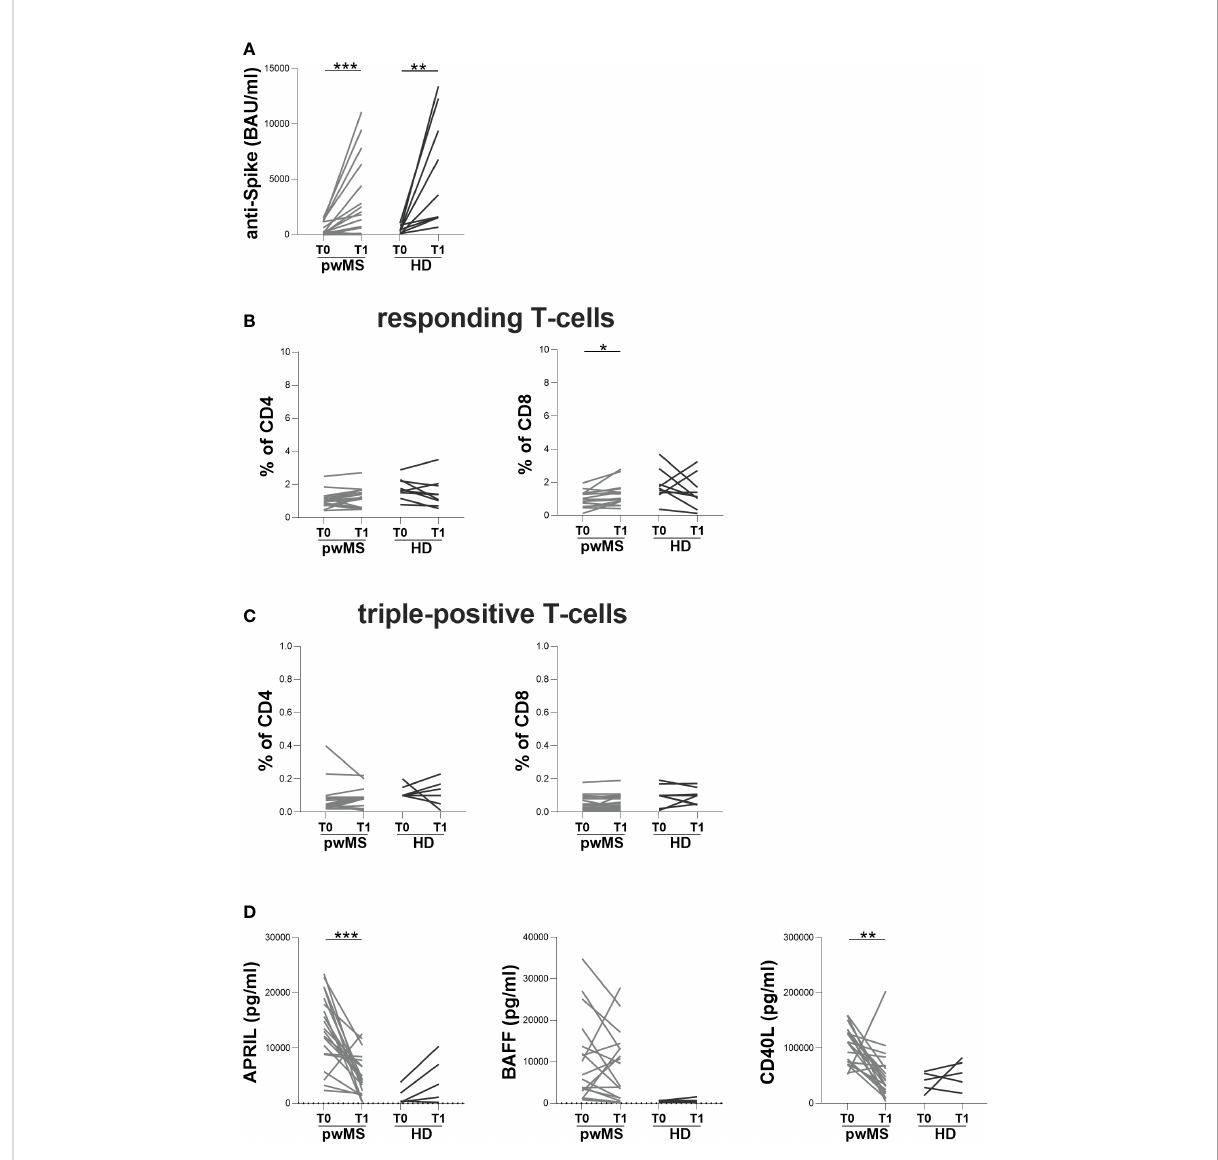
FIGURE 3 Longitudinal evaluation of humoral and speci fi c T-cell response in pwMS and HD. (A) The longitudinal evaluation of anti-S antibody titers in pwMS and HD. (B) The evaluation of responding CD4+ and CD8+ T-cells in pwMS and HD. (C) The evaluation of triple-positive CD4+ and CD8+ T-cells in pwMS and HD. (D) The longitudinal evaluation of plasma levels of APRIL, BAFF and CD40L. APRIL, A-proliferation inducing ligand; BAFF, B-cell activating factor; CD40L, CD40 ligand; pwMS, people with multiple sclerosis; HD, healthy donors; T0, before third dose of vaccine; T1, after two months from third dose of vaccine. *p < 0.05; **p < 0.01; ***p <